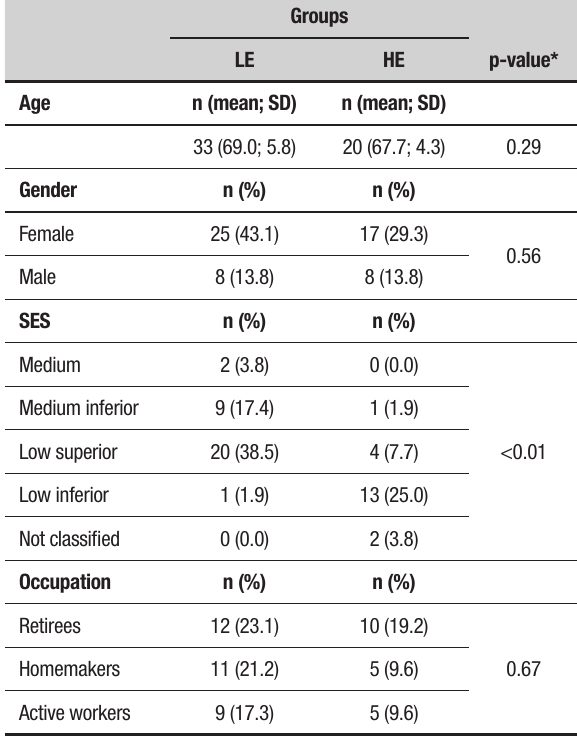
Table 1. Demographic